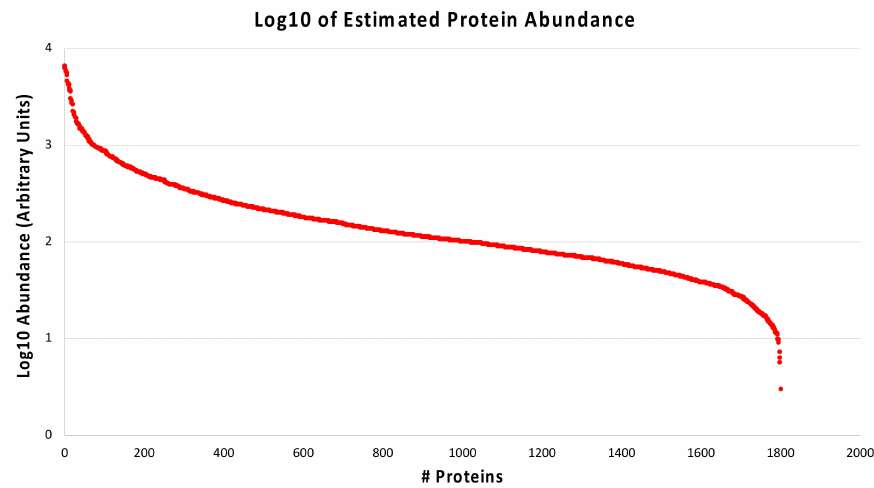
Figure 6. Distribution of protein abundances. The average protein abundance estimated for the entire protein set is shown in a logarithmic scale (Arbitrary Units) and spans 4 orders of magnitude. This range was divided into 8 intervals, and proteins clustered in each interval were analyzed for their interactions and functional enrichment using STRING v. 11.0, DAVID v. 6.7, and Revigo. Results were filtered to keep only significant enriched terms with a minimum of 4 counts and a p value < 0.001. The complete results are reported in Table S7 and graphically displayed in Figure S2. A summary of this analysis is reported in Table 5, where Log2 abundance intervals, the number of proteins falling in each interval, and their functional characterization are listed. Table 5. Gene Ontology annotation of proteins grouped according to their average abundance. Proteins are grouped in 8 arbitrary ranges of abundance (expressed as Log2 of arbitrary units), and the most enriched and significant GO terms (Biological Process, Cellular Component, Molecular Function, and KEGG pathways) are listed for each